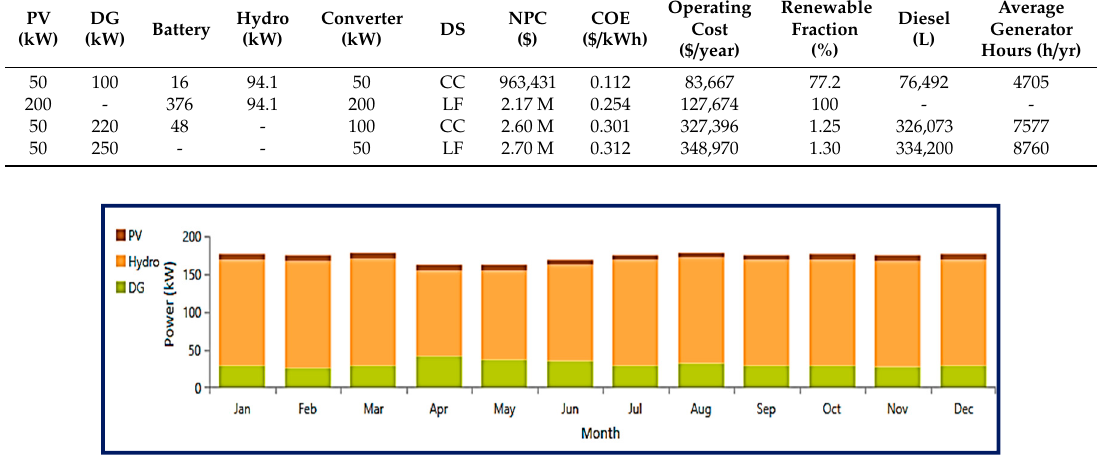
Figure 10. Monthly average fuel consumption of a 100 kW diesel generator (DG).